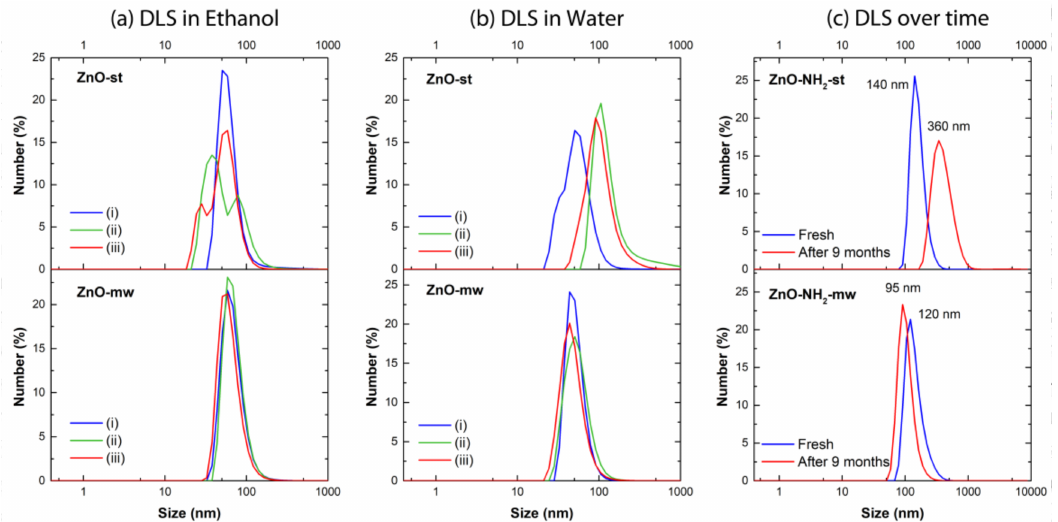
Figure 5. Dynamic light scattering (DLS) measurements in number % of pristine ZnO NCs obtained via traditional synthesis (ZnO-st, top panel) and via microwave route (ZnO-mw, bottom panel) in ( a ) ethanol; ( b ) water; ( c ) of functionalized ZnO particles (ZnO-NH 2 -mw and ZnO-NH 2 -st) in ethanol just after the functionalization procedure (solid line) and after nine months of storage (dashed